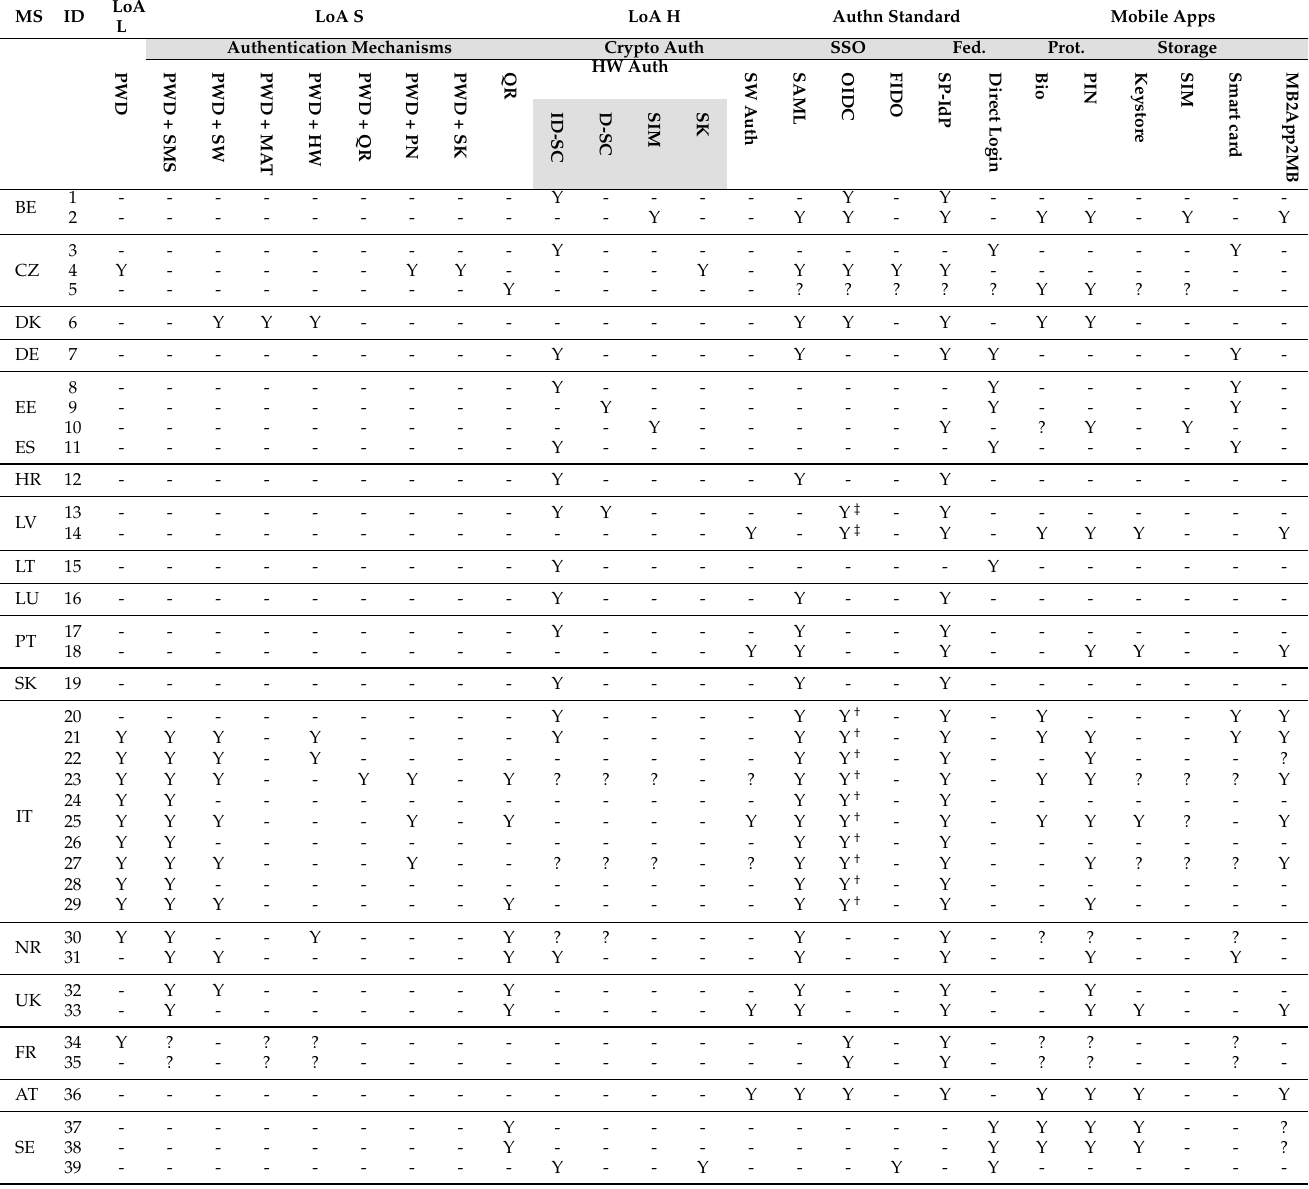
Table 2. Analysis results of notified eID schemes for RQ1, RQ2, and